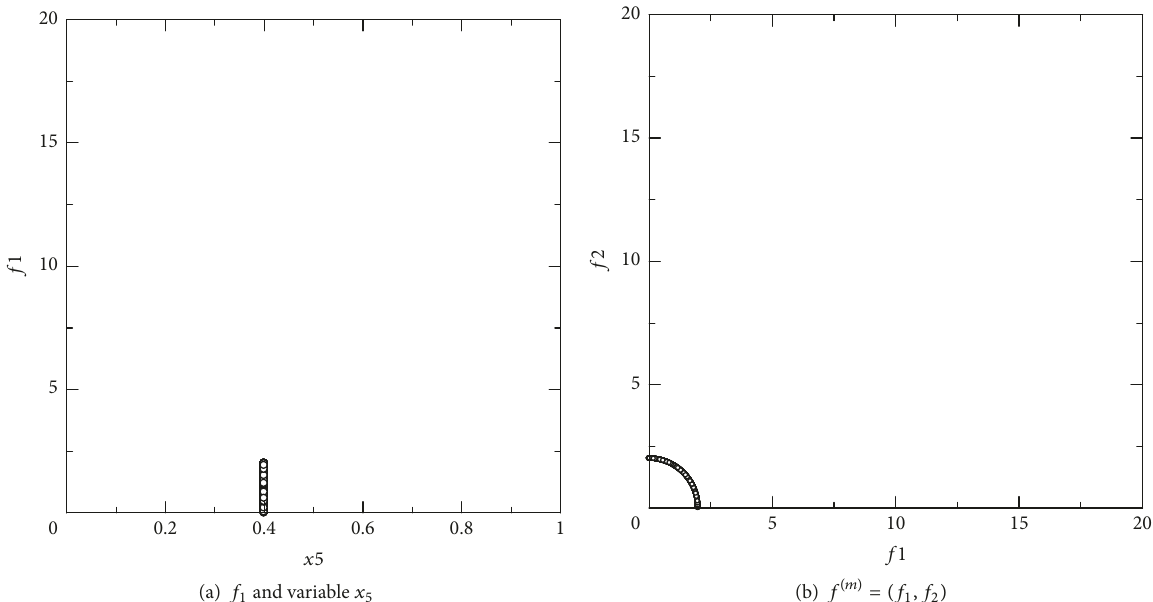
Figure 5: Conventional NSGA-II searching on original space 𝑓 (𝑚) = (𝑓 1 ,𝑓 2 ) , 𝑛 = 5 , restricting variable 𝑥 5 to the range [0.29, 0.41] .